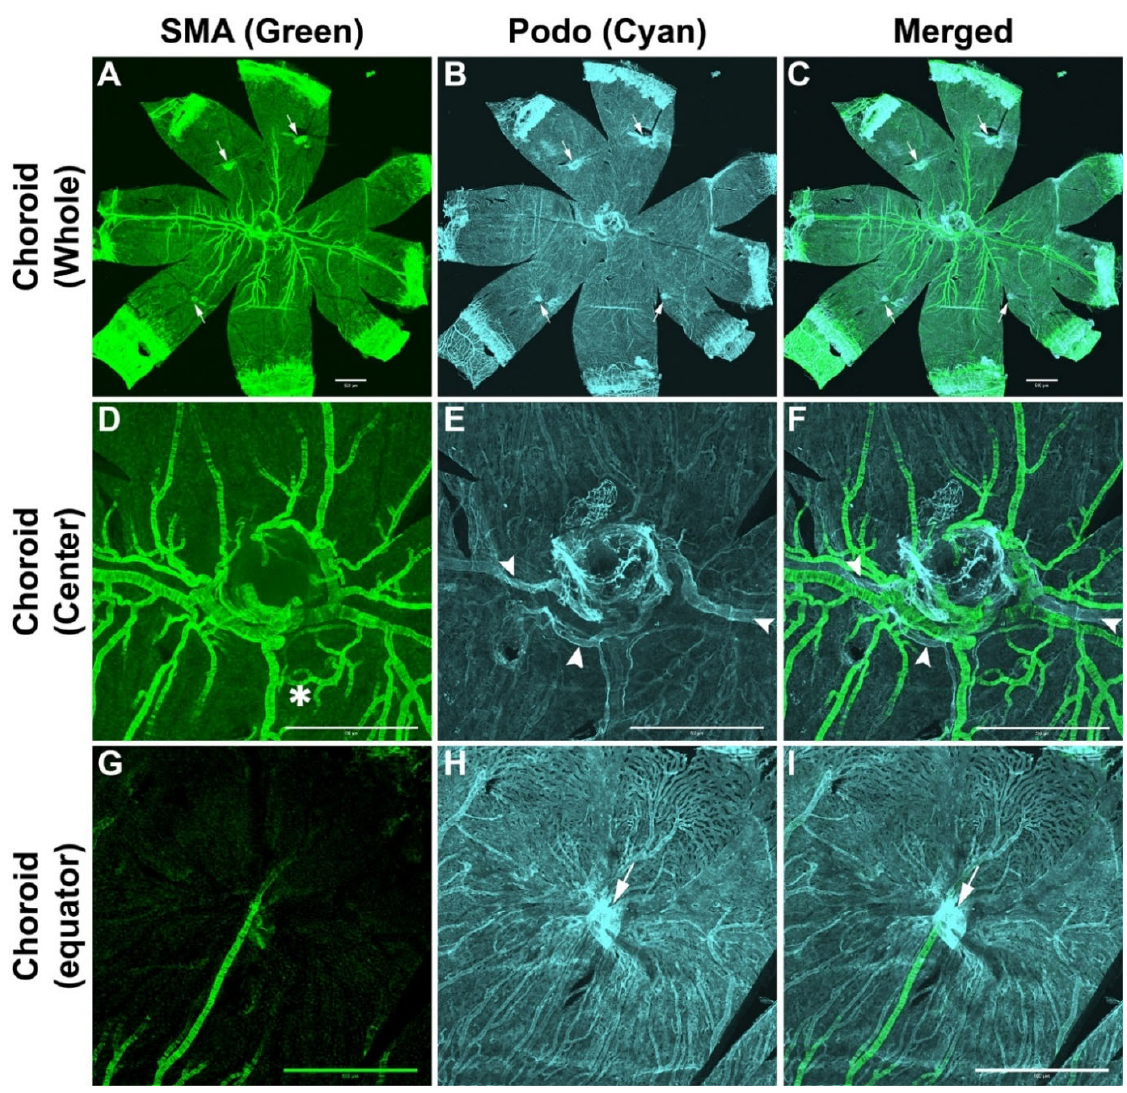
Figure 1. Visualization of the arterial and venous systems of the mouse choroid. ( A , D , G ) The anti- α -SMA staining labels the major arterial system in the choroid. The two long posterior ciliary arteries (LPCAs) extend nasally and temporally. It is obvious that LPCAs feed the entire choroidal vasculature. LPCAs send branches around the optic disc as it appears from the α -SMA staining, forming a vascular circle, such as the Zinn–Haller arterial circle in the choroids of humans and primates. Secondary arteries sometimes form loops ( D , asterisk). At least two major LPCA-derived arteries feed the superior and inferior parts of the choroid. LPCAs and their major LPCA-derived arteries run perpendicular to each other, dividing the choroid into four quadrants. ( B , E , H ) Anti-podocalyxin staining strongly labels most of the choroidal vasculature except the arterial system, especially in the center of the choroid. Four vortex veins are observed at the equator of the choroid (arrows). A second venous system can be seen in the center of the choroid (arrowheads). These central veins appear to drain blood from the center of the choroid. ( C , F , I ) Merged images from staining with anti- α -SMA and anti-podocalyxin antibodies show the detailed structure of all choroidal components, including arteries, veins, and choriocapillaris. Thus, both venous systems in the choroid are more easily identified with respect to the rest of the vasculature, especially arteries. Number of choroids examined = 6. All representative images were from a 3-week-old FVBN mouse and captured using a confocal microscope. Scale bars: 500 µ